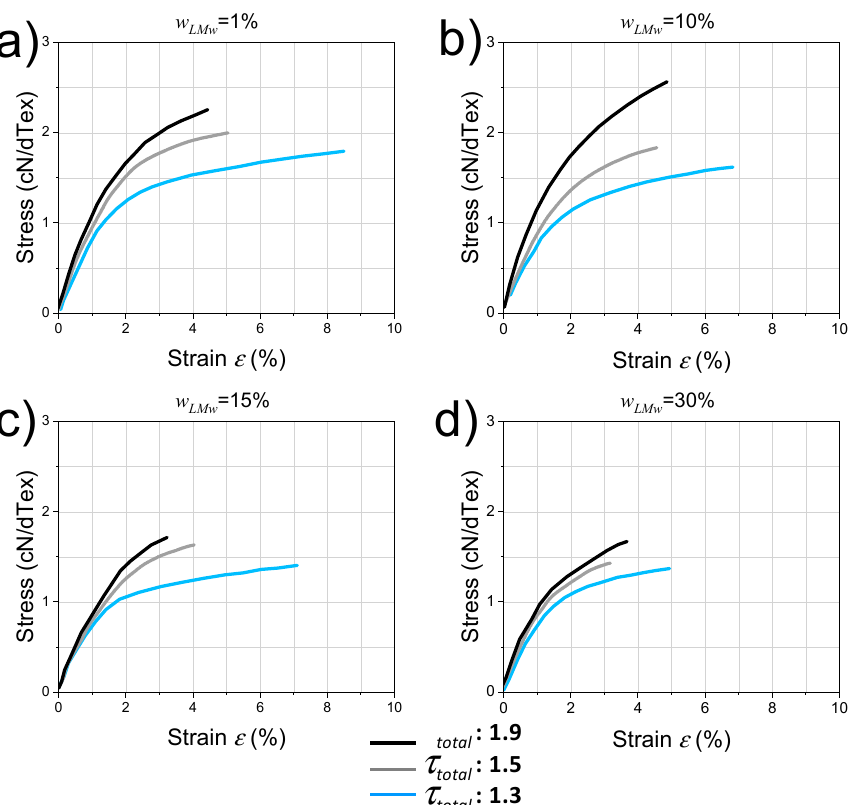
Figure 7. Typical nominal stress (in Textile units cN/dTex) vs. nominal strain curves for spun fibers with different LMW chitosan contents w LMW , and for stretching ratios τ total = 1.3, 1.5 and 1.9. ( a ): w LMW = 1%; ( b ): w LMW = 10%; ( c ): w LMW = 15% and ( d ): w LMW = 30%.